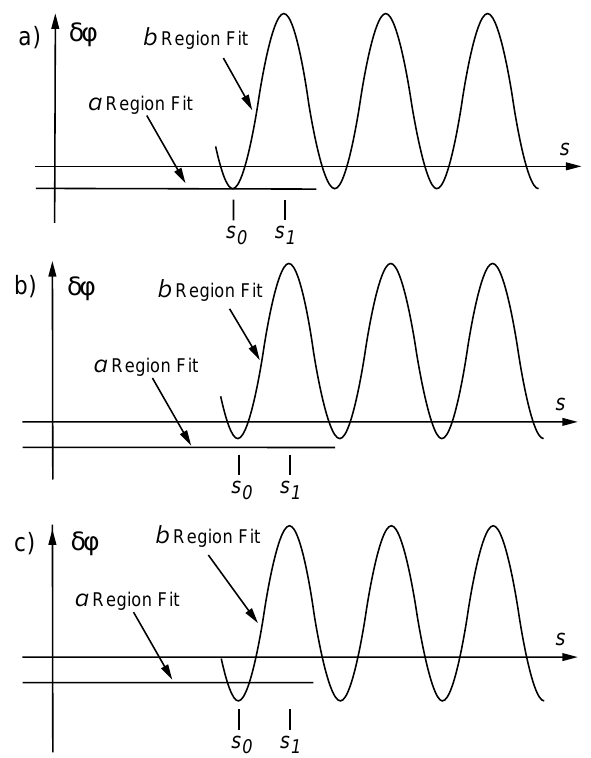
FIG. 2. In theory, the a and b region fits of df (cid:1) s (cid:2) are continu- ous and have a continuous derivative at s 0 , as shown in (a). (For simplicity, the a region fit is taken here to be a straight line.) In practice the fits to the a and b regions may (b) fail to intersect or (c) intersect with a discontinuous derivative. The best guess for the location of the error (labeled s 0 ) is where the deriva- tives match and where any discontinuity is smaller than A f (cid:3) 2 (so that the point labeled s 1 is rejected as a possible location for the error).